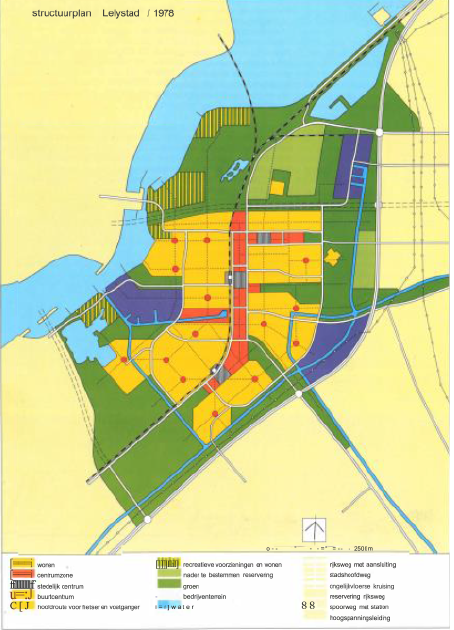
Figure 7. Structure plan 1978. Source: Constandse